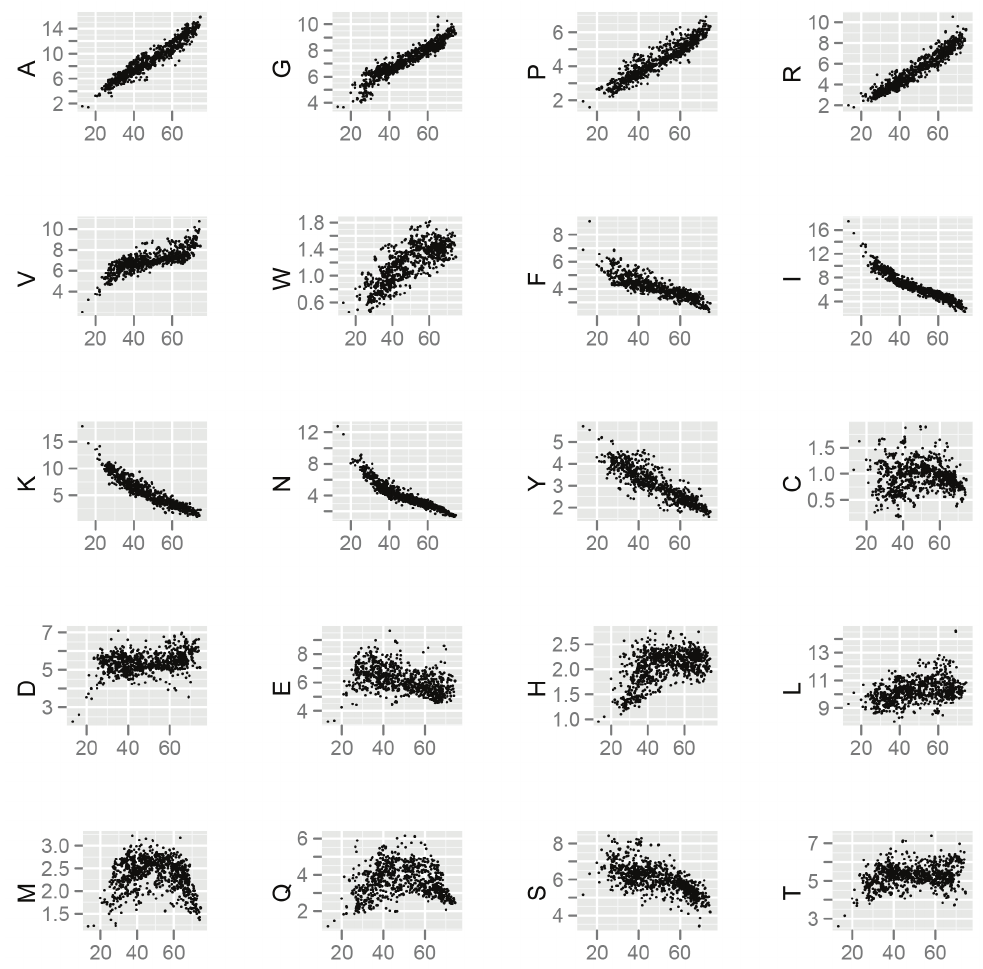
Figure 3. Composition of basic amino acids over ~1100 eubacterial genomes. The x-axis of each subplot shows for GC composition of each genome whereas y-axis shows corresponding amino acid